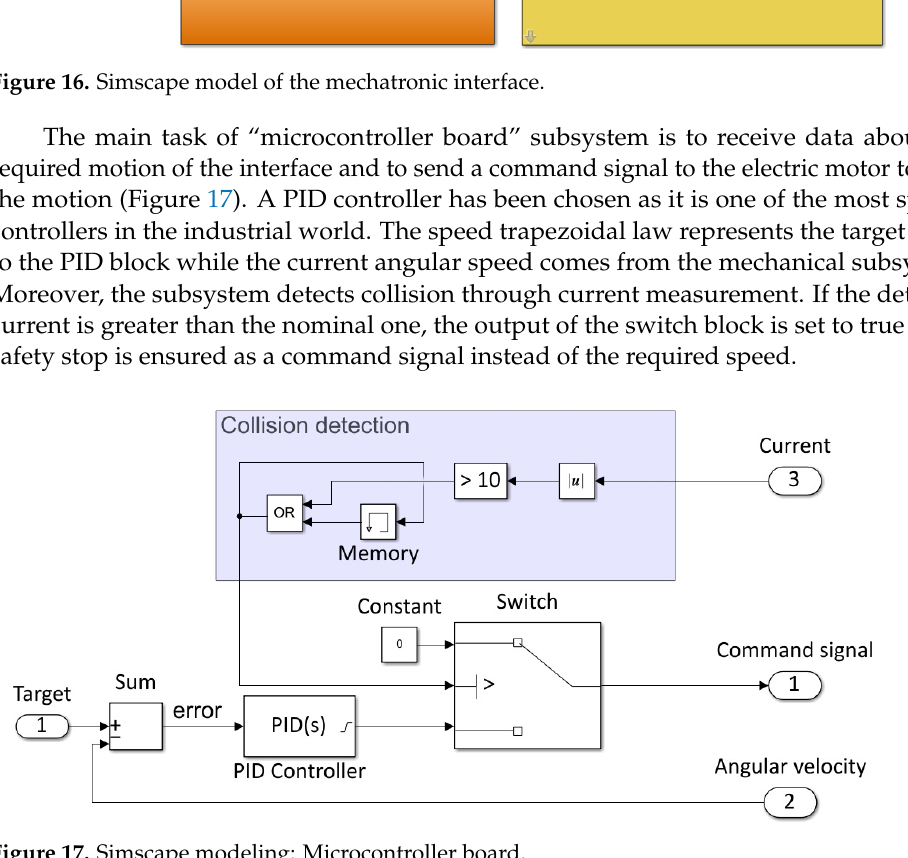
Figure 17. Simscape modeling: Microcontroller